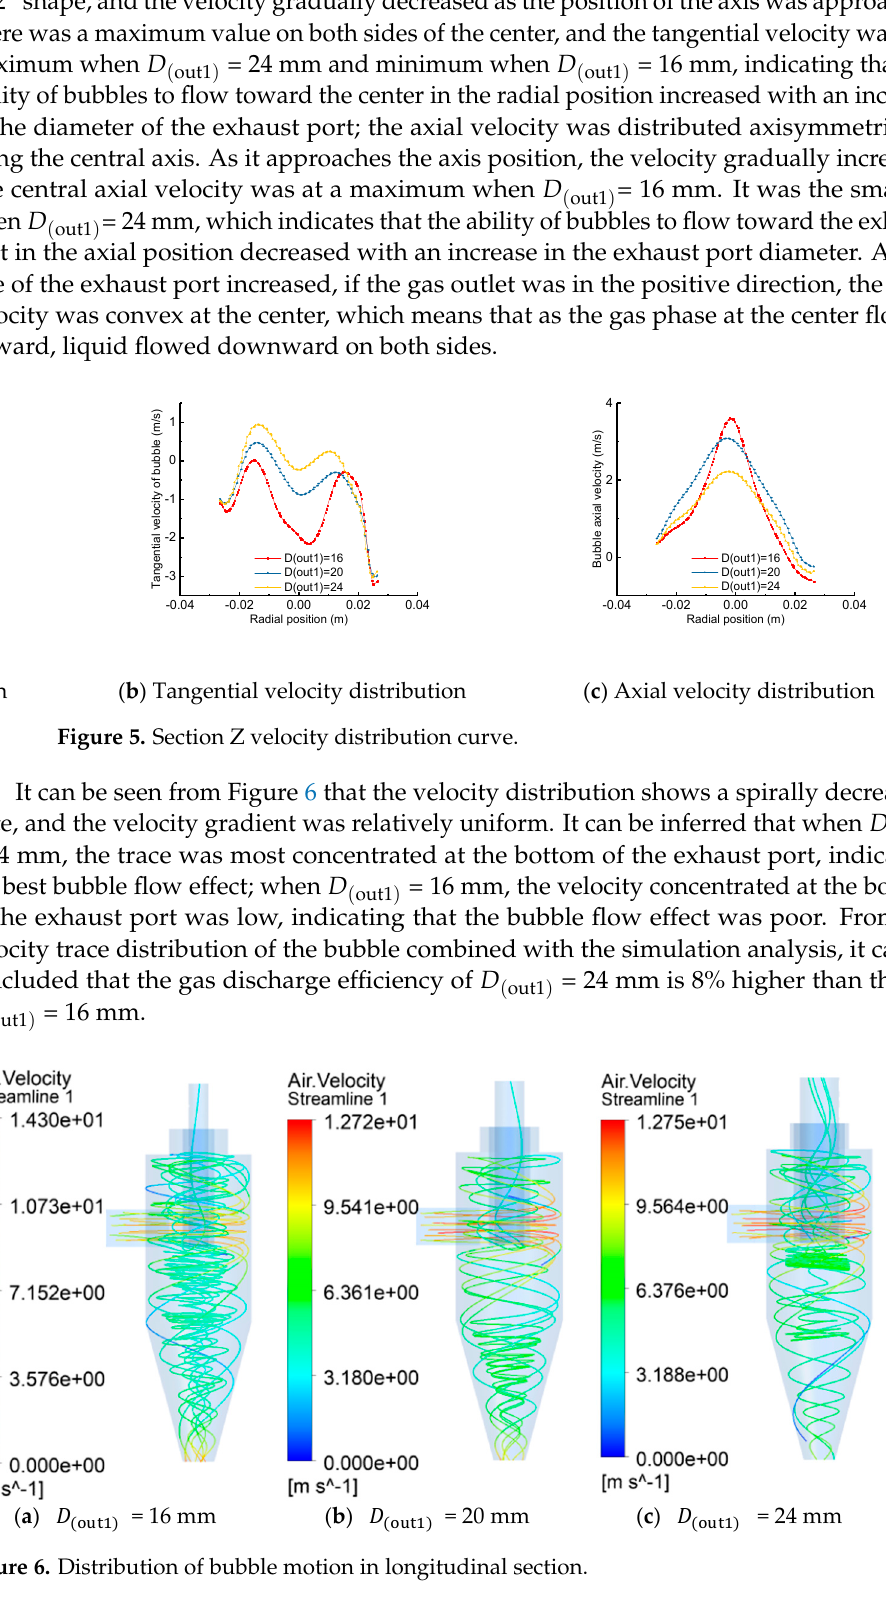
( c ) Rectangular inlet Figure 7. Pressure distribution nephogram of section Z.